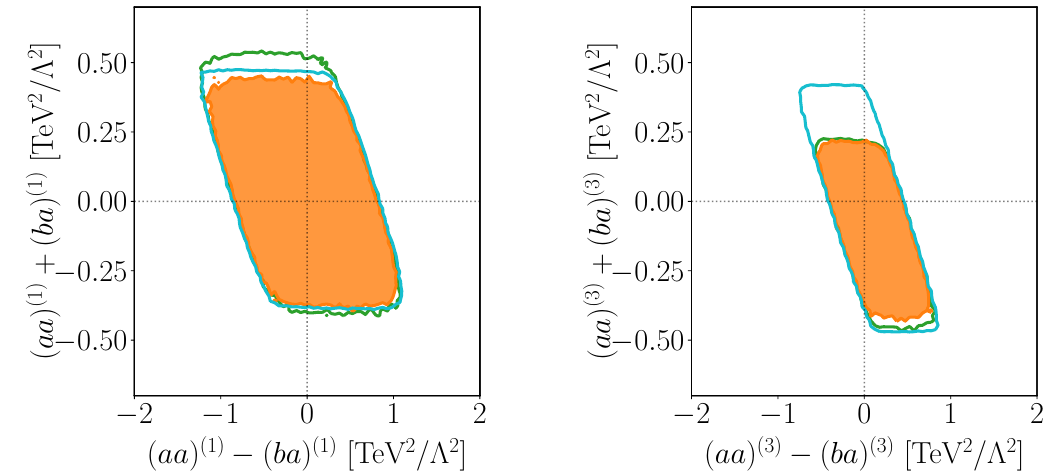
Figure 5 . Bounds on flavor-universal versus singly flavor-breaking four-quark couplings, ( aa ) ( w ) and ( ba ) ( w ) , for weak singlets (left) and weak triplets (right). Shown are likelihood contours of ∆ χ 2 = 5 . 99 for data set 1 (cyan), set 2 (green) and set 3 (orange). The area inside the contours is in agreement with the data. The flavor parameters are defined at µ